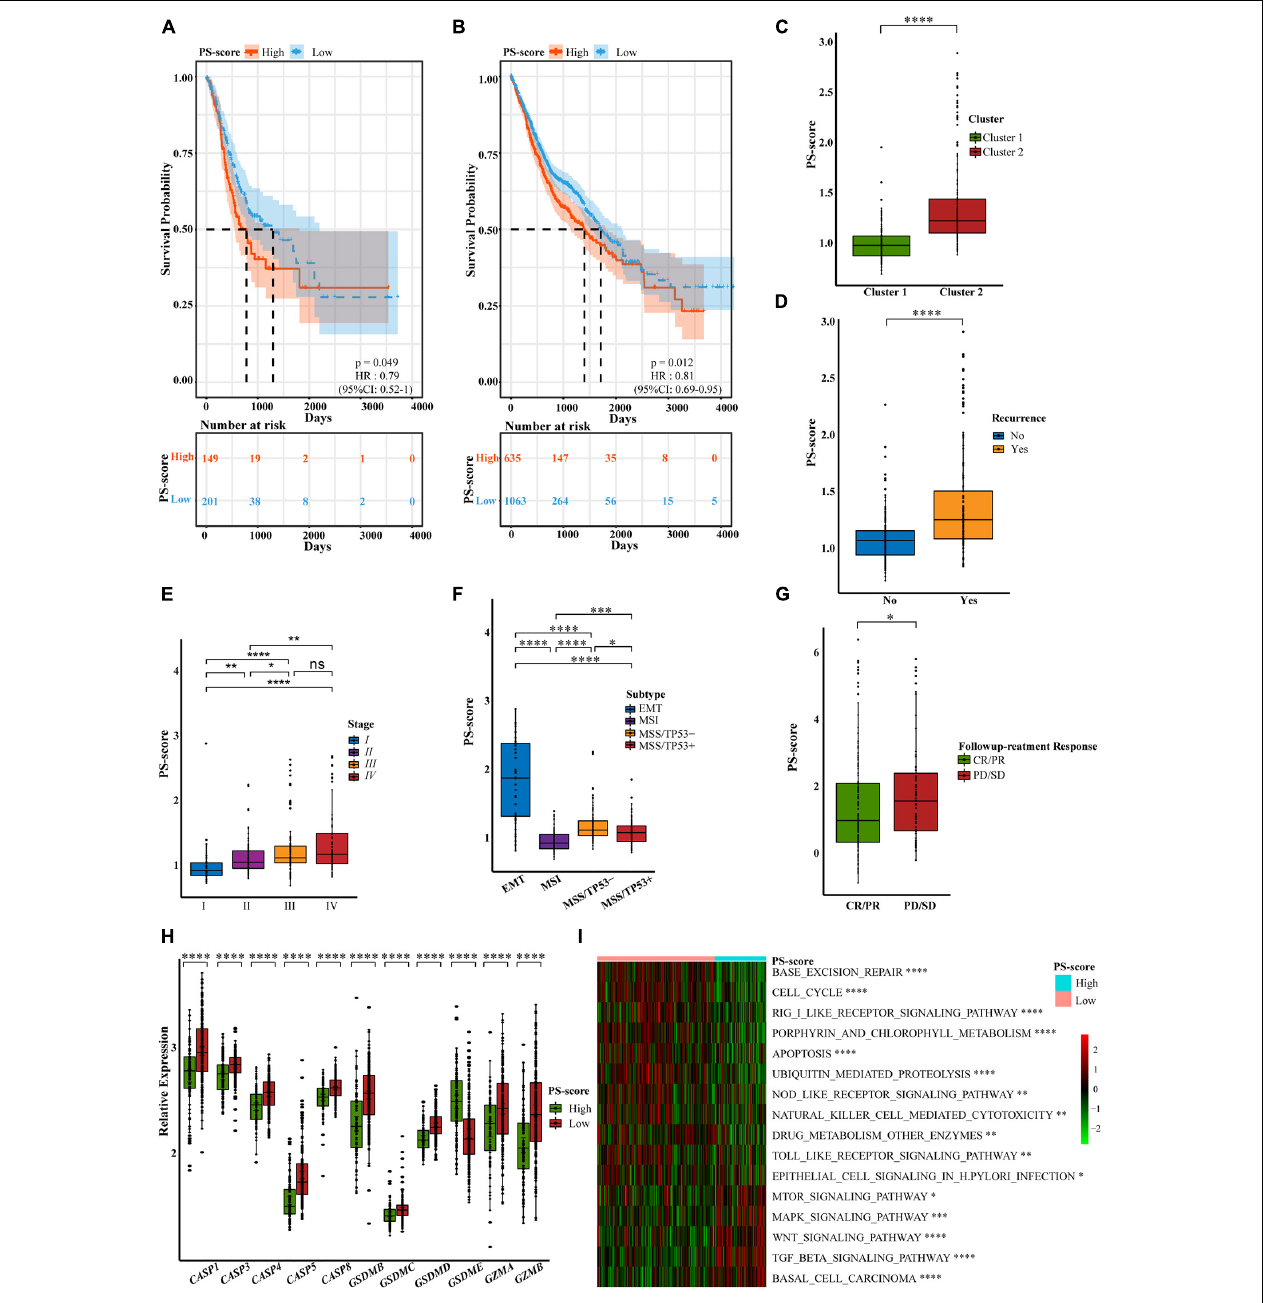
FIGURE 5 | Characteristics of the PS-score scoring model. (A) OS curves for the PS-score with the cut-off value 1,258 of gastric cancer samples in TCGA-STAD cohort (Log-rank test, p = 0.049). (B) OS curves for the PS-score with the cut-off value 1,258 of 1,698 gastrointestinal cancer patients in TCGA cohorts (CHOL, COAD, ESCA, LIHC, PAAD, READ, and STAD) (Log-rank test, p = 0.012). (C–G) PS-score in different clinical trait constituents including pyroptosis-related cluster, recurrence status, TNM staging, ACRG subtype in GSE62254 cohort, and followup treatment response in TCGA-STAD (Wilcox test, ∗ P < 0.05; ∗∗ P < 0.01; ∗∗∗ P < 0.001; ∗∗∗∗ P < 0.0001; ns, not statistically significant). (H) Differential expression of pyroptosis-related regulators in low PS-score subgroup ( n = 209) and high PS-score subgroup ( n = 91) of GSE62254 cohort (Wilcox test, ∗∗∗∗ P < 0.0001). (I) Visualization of biological processes analyzed by GSVA in distinct PS-score subgroups (Bayes moderation, ∗ P < 0.05; ∗∗ P < 0.01; ∗∗∗∗ P < 0.001; ∗∗∗∗ P <